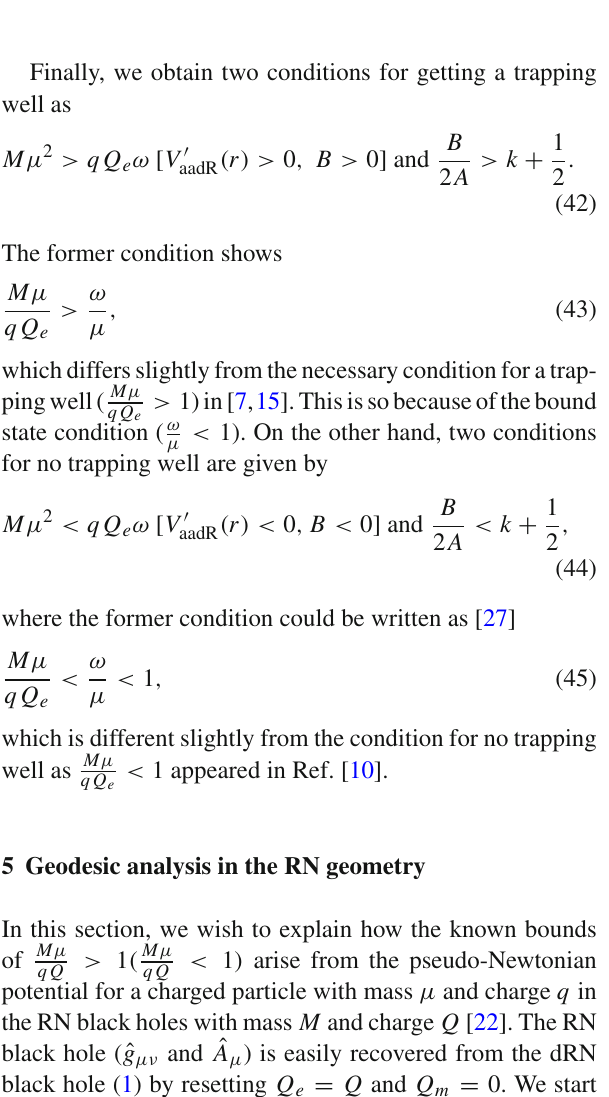
found inside the outer horizon at r = r + ( • ). We note ω < ω c ( = 4 . 75 ) ( r ) > 0. (Right) Far-region scalar (cid:17) ( r ) and its and ω < μ with V (cid:15) 4 aadR ( r ) (cid:17) (cid:17) ( r ) represent a half of a peak asymptotic form (cid:17) A 4 4